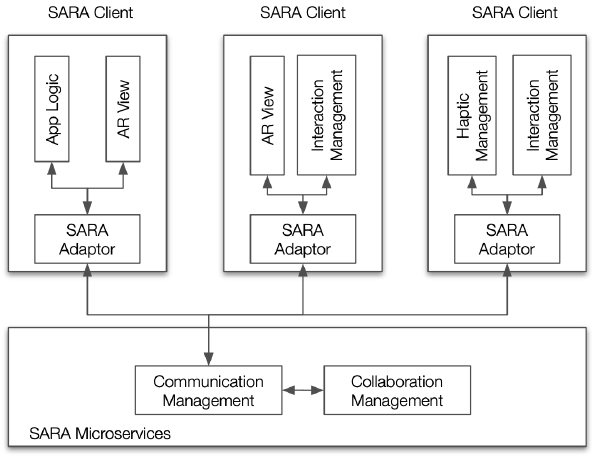
Figure 3. Overview of the SARA architecture, with its communication and collaboration management microservices and clients.